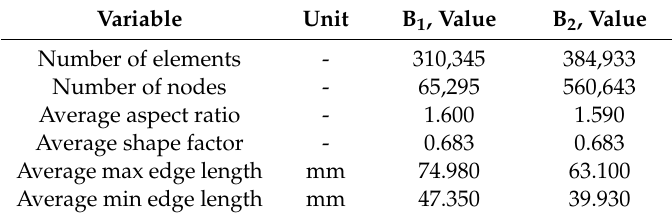
Figure 24. Mesh generated for the mechanical simulation, the BIM building element E 2 . Table 8. Statistics of the discrete mesh associated with the BIM E 1 and E 2 constructive elements.